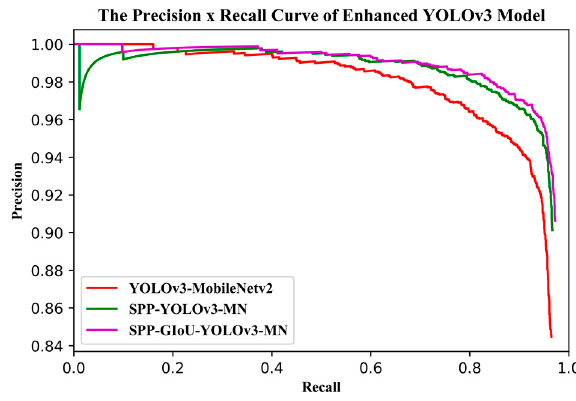
Figure 13. PR curve of the enhanced YOLOv3 model.